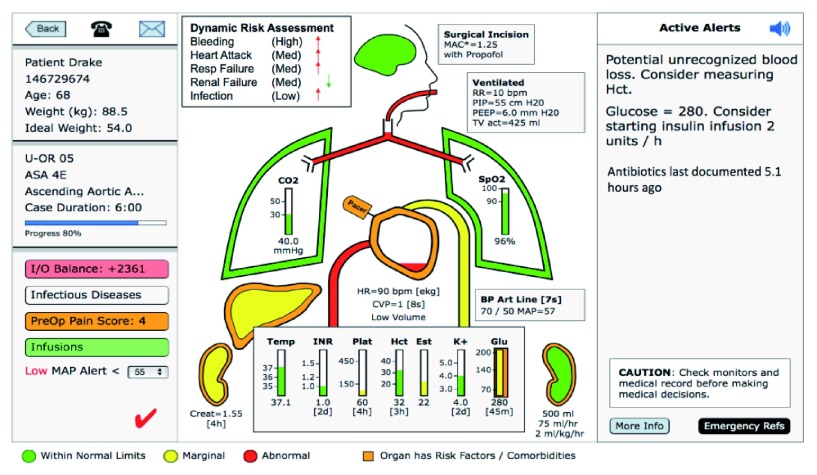
Summary overview data for a hypothetical patient (AlertWatch® ACT Dashboard).